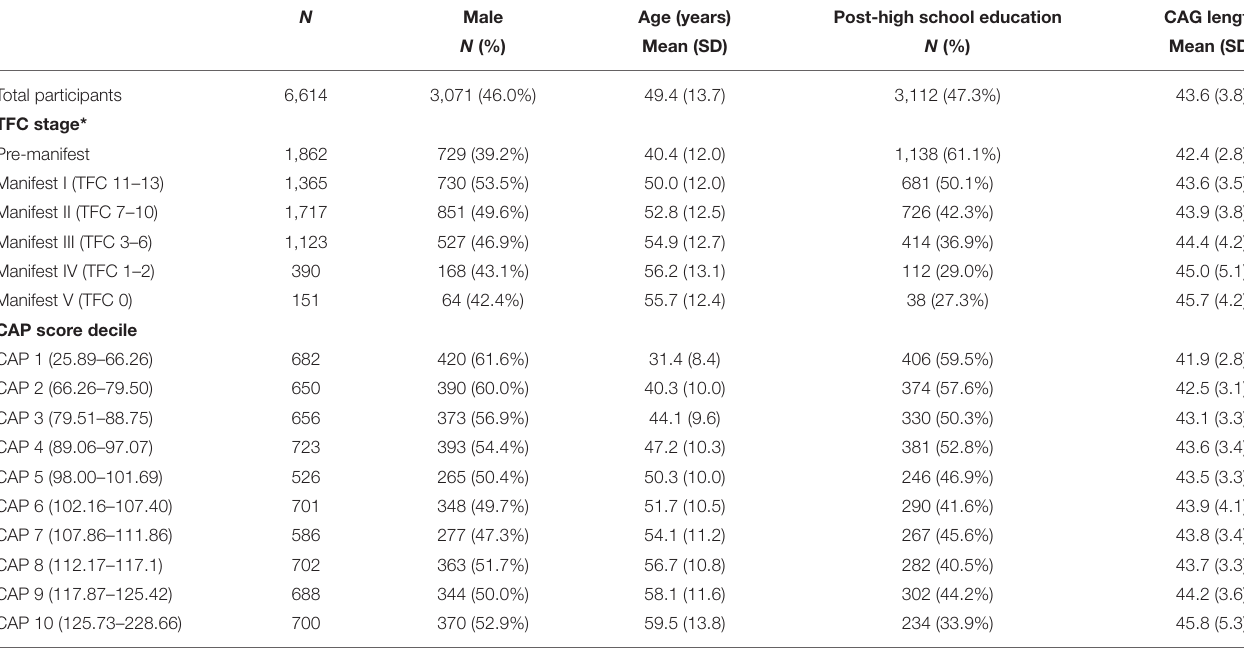
TABLE 1 | Participant characteristics at baseline visit (global and stratified by disease